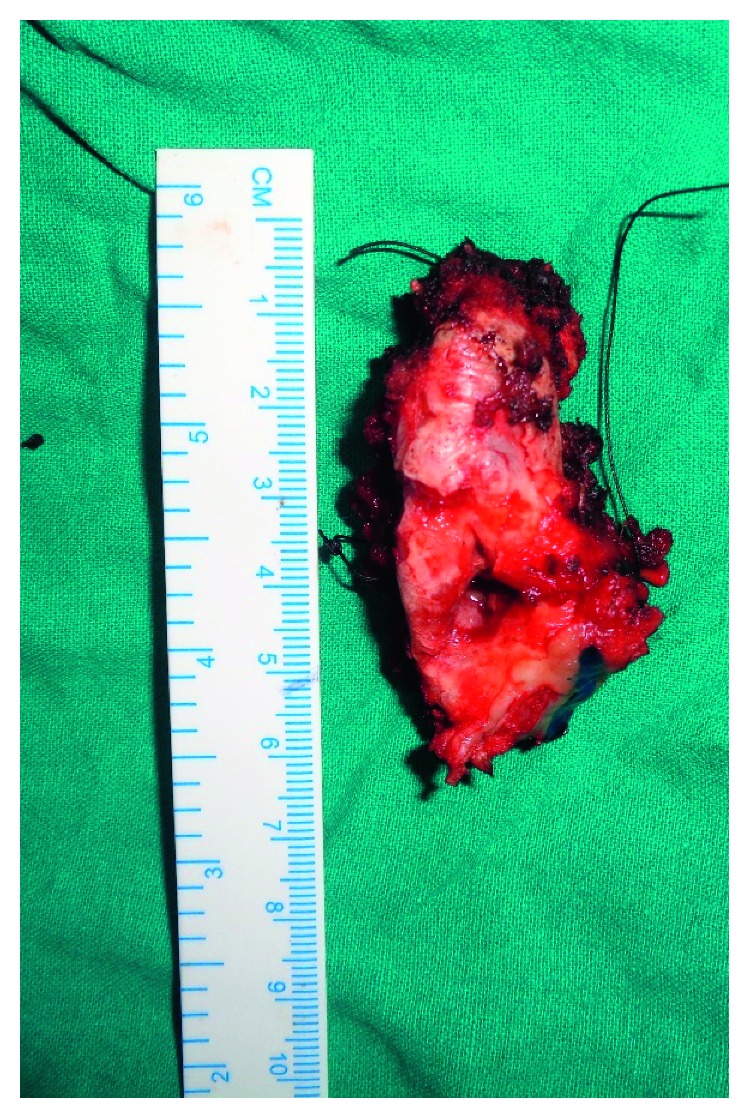
Surgical specimen.